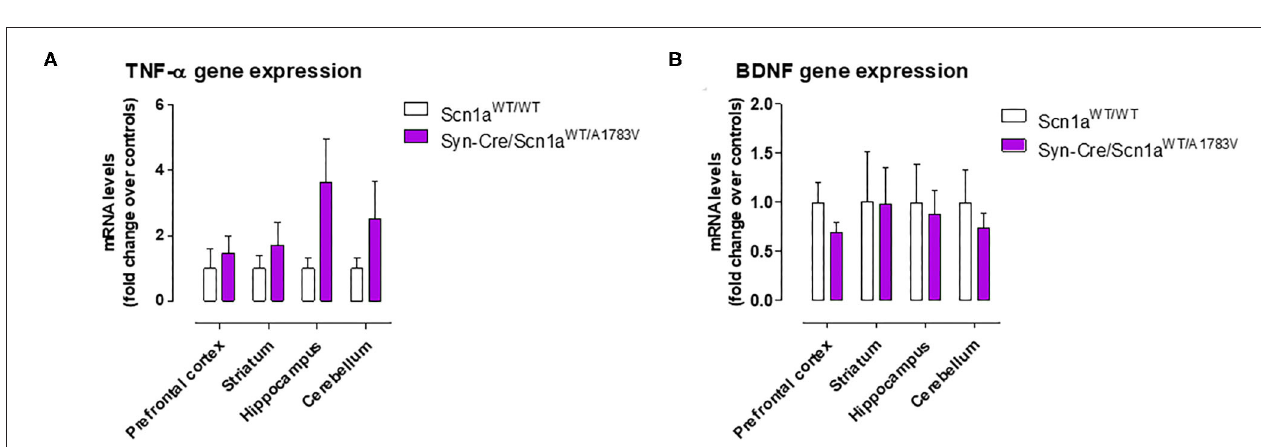
FIGURE 8 | Gene expression for TNF- α and BDNF measured by qPCR in different CNS structures of Syn-Cre/Scn1a WT / A1783V mice compared with Scn1a WT / W animals at PND25. Values are fold of change over controls and correspond to means ± SEM of five to six animals per group. Data were assessed by the Student’s t